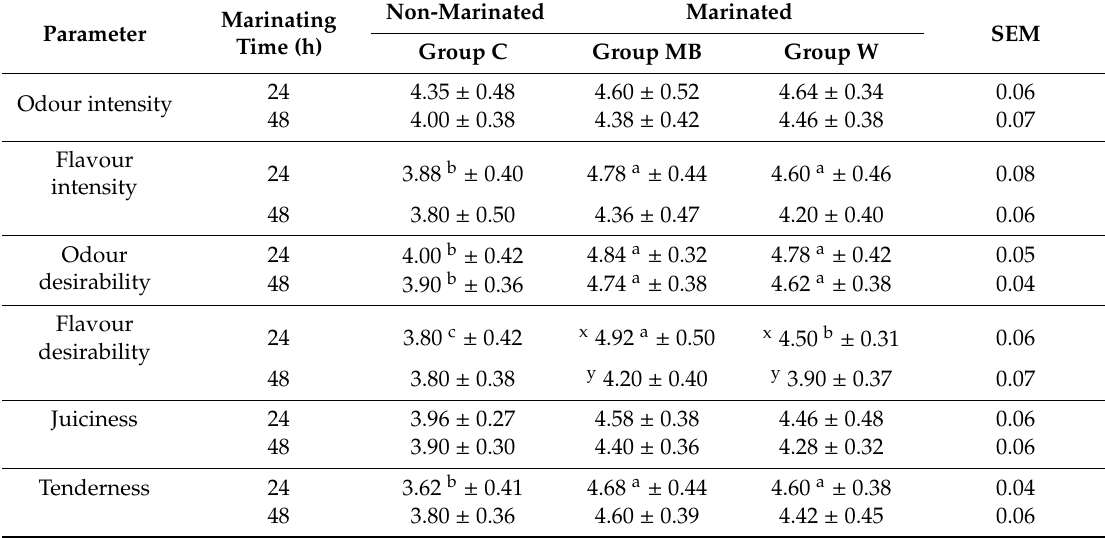
Table 4. E ff ect of marinating on sensory properties of roast